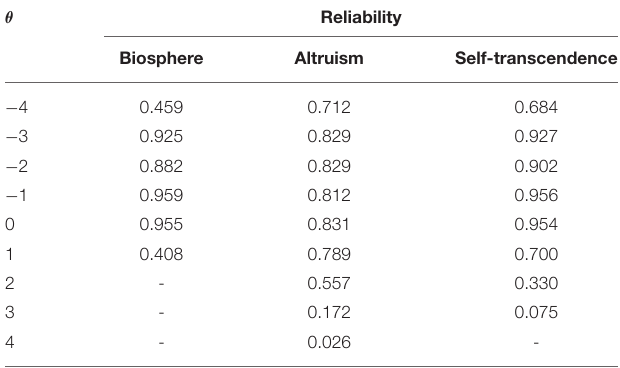
TABLE 3 | Reliability for the human values of θ ( theta ) from the GRM model.